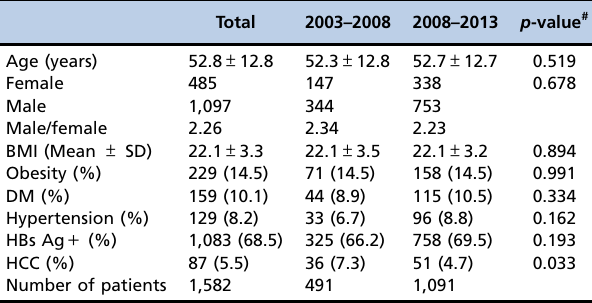
Table 2 - Clinical characteristics of cirrhotic